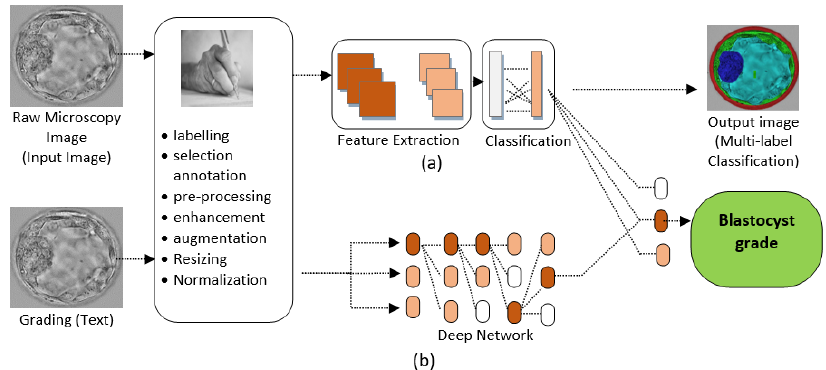
Figure 6. Example of deep learning models for ART ( a ) Generative model. CNN can be trained to generate images including tasks of image pre-processing, image enhancement, image augmentation and/or others. ( b ) Multimodal discriminative model. Deep learning architectures can be constructed to jointly learn from images (typically with CNN) and non-image data (typically with general deep networks).